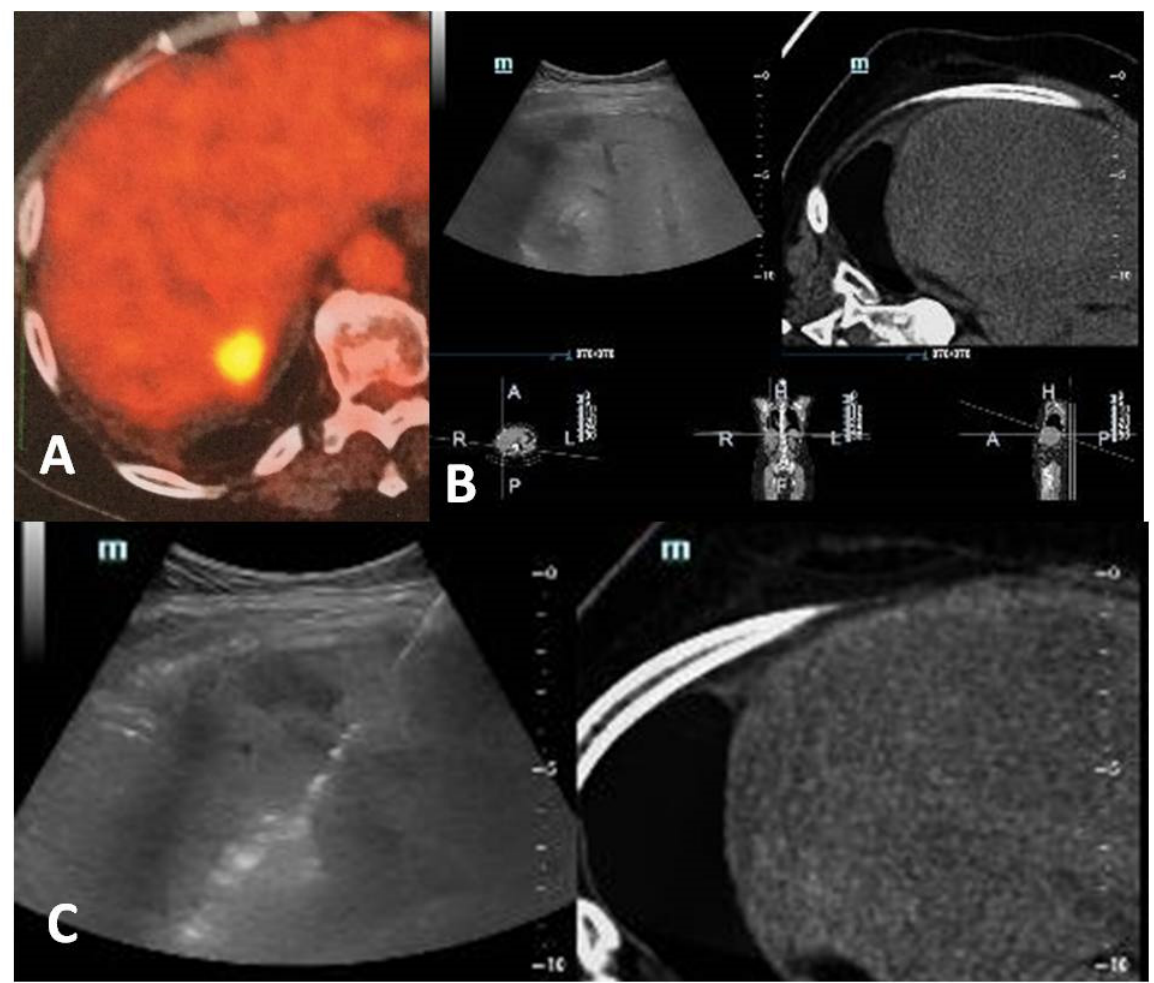
Figure 1. A 60-year-old, female patient with a medical record of colorectal cancer and synchronous liver metastasis for which underwent surgery and chemotherapy presented with a PET avid new hepatic lesion ( A ). Contrast-enhanced computed tomography scan was not possible due to prior severe allergic responses; fusion imaging was used for ablation guidance ( B ). A radiofrequency electrode was inserted under fusion imaging, and ablation was performed with no need for iodinated contrast medium ( C